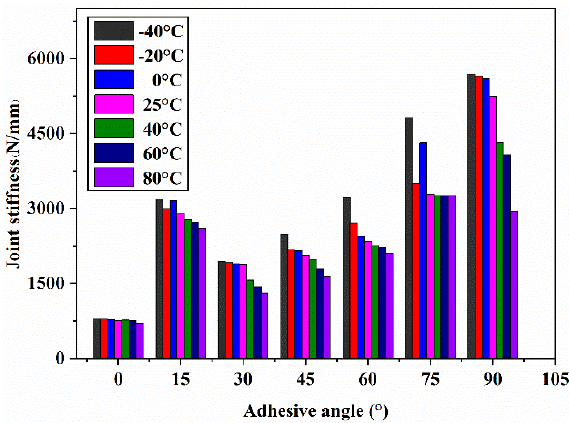
Figure 13. Column diagram of joint stiffness varying with temperature.